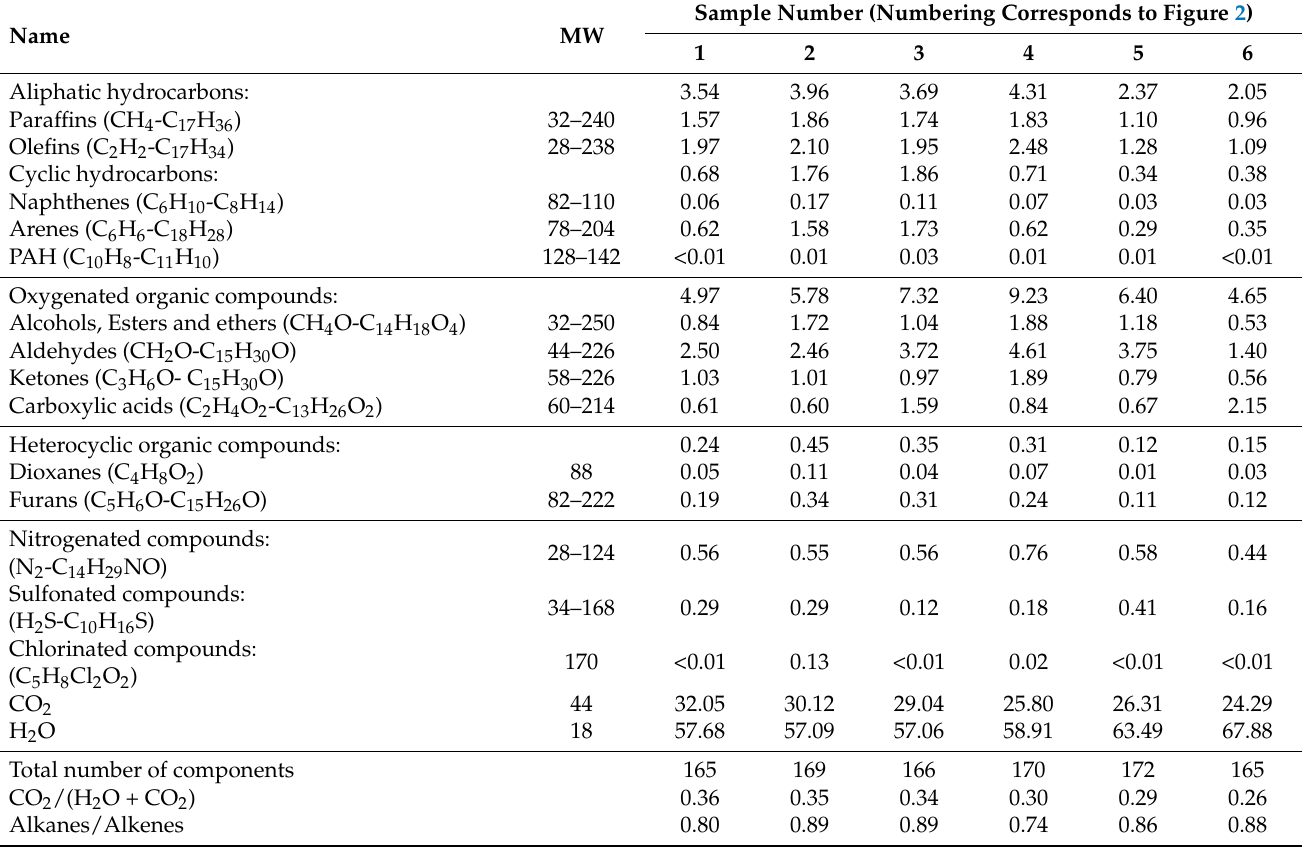
Table 2. Composition of volatile components (based on 6 samples) released during mechanical destruction of cordierite from the Muzkol metamorphic complex, according to GC-MS analysis (rel.%).